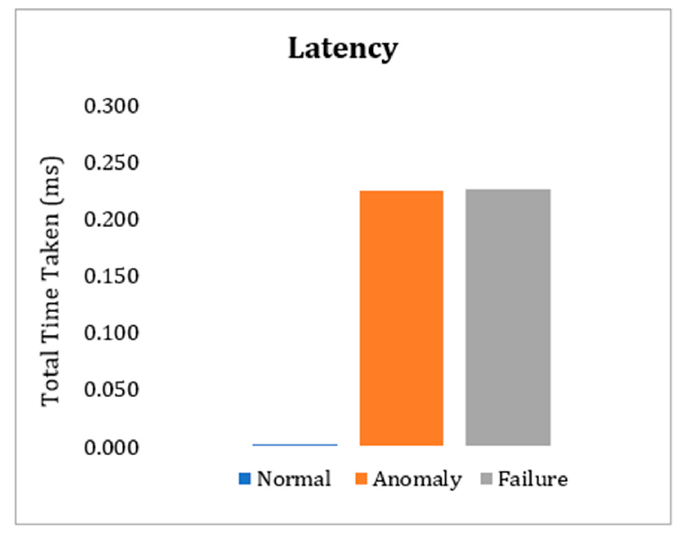
Figure 15. Latency